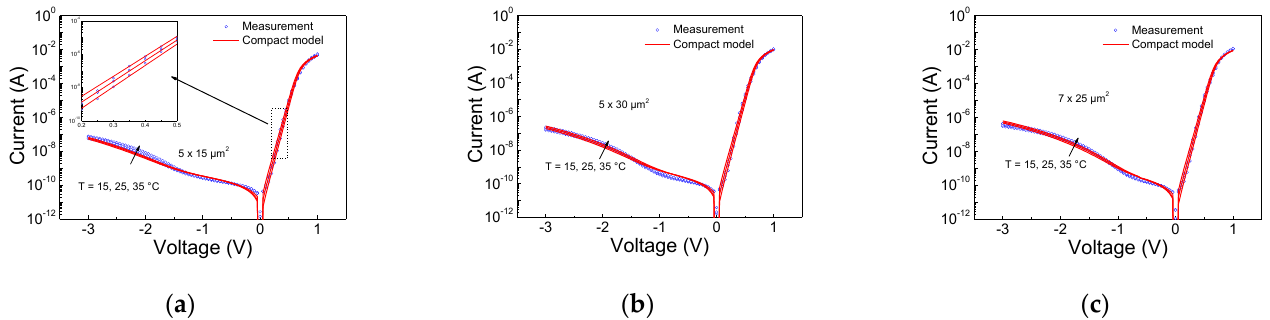
Figure 6. Measured (symbol) and simulated (line) current–voltage–temperature of UTC-PD with an active area of ( a ) 5 × 15 µm 2 ( b ) 5 × 30 µm 2 ( c ) 7 × 25 µm 2 .